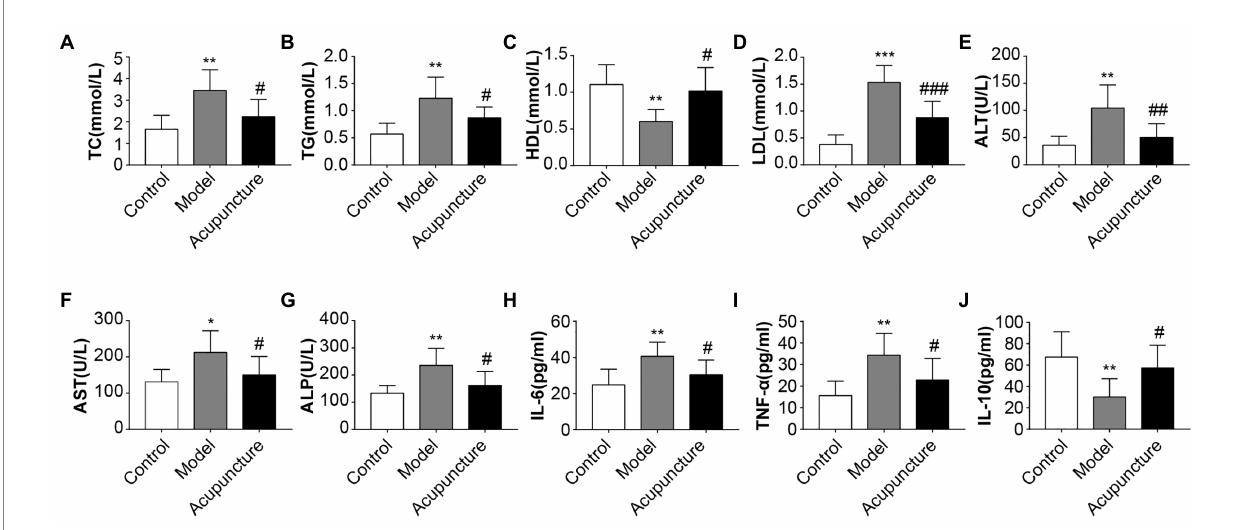
FIGURE 2 Impact of acupuncture on serum lipid metabolism and inflammation in non-alcoholic fatty liver disease (NAFLD) rats. Serum lipid metabolism parameters (A–G) , Serum inflammatory factors (H–J) . (A) Serum total cholesterol (TC). (B) Serum triglycerides (TG). (C) Serum high-density lipoprotein cholesterol (HDL). (D) Serum low-density lipoprotein cholesterol (LDL). (E) Serum alanine transferase (ALT). (F) Serum aspartate transferase (AST). (G) Serum alkaline phosphatase (ALP). (H) Serum interleukin (IL)-6. (I) Serum tumor necrosis factor-alpha (TNF- α ). (J) Serum interleukin (IL)-10. Data are shown as mean ± SD. * p < 0.05, ** p < 0.01, *** p < 0.001, Control vs. Model; # p < 0.05, ## p < 0.01, ### p < 0.001, Model vs.